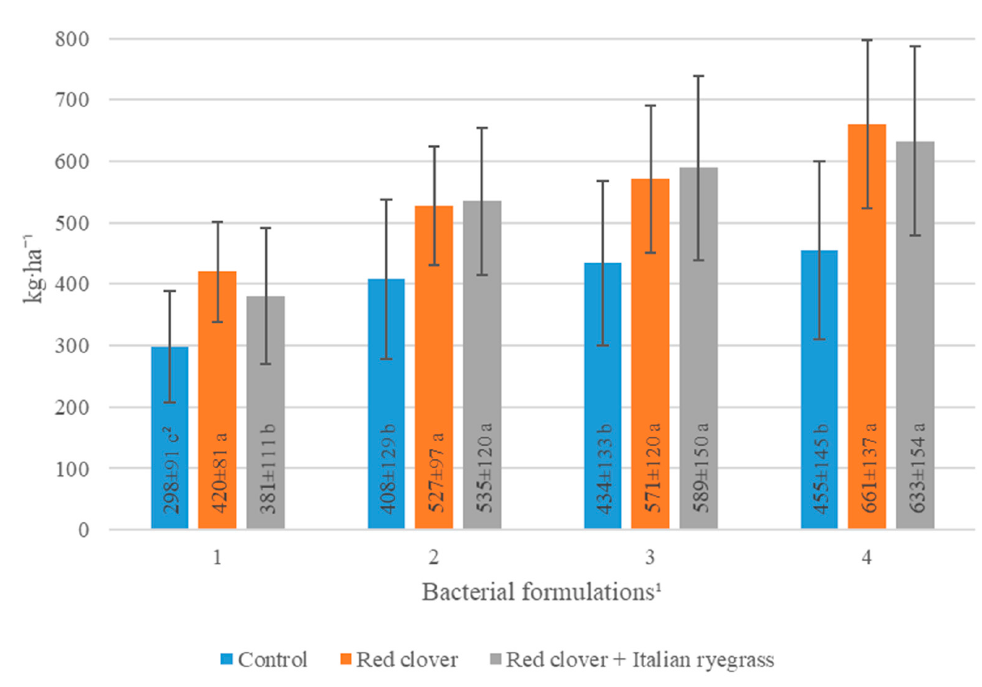
Figure 4. Total protein yield in spring barley grain according to test bacterial formulations and companion crops (means across 2019–2021), kg ∙ ha − 1 . 1 For explanations see Table 1. 2 Values in bacterial formulations for the interaction followed by the same small letter (a, b, c) do not differ significantly at p < 0.05. ±, standard deviation.